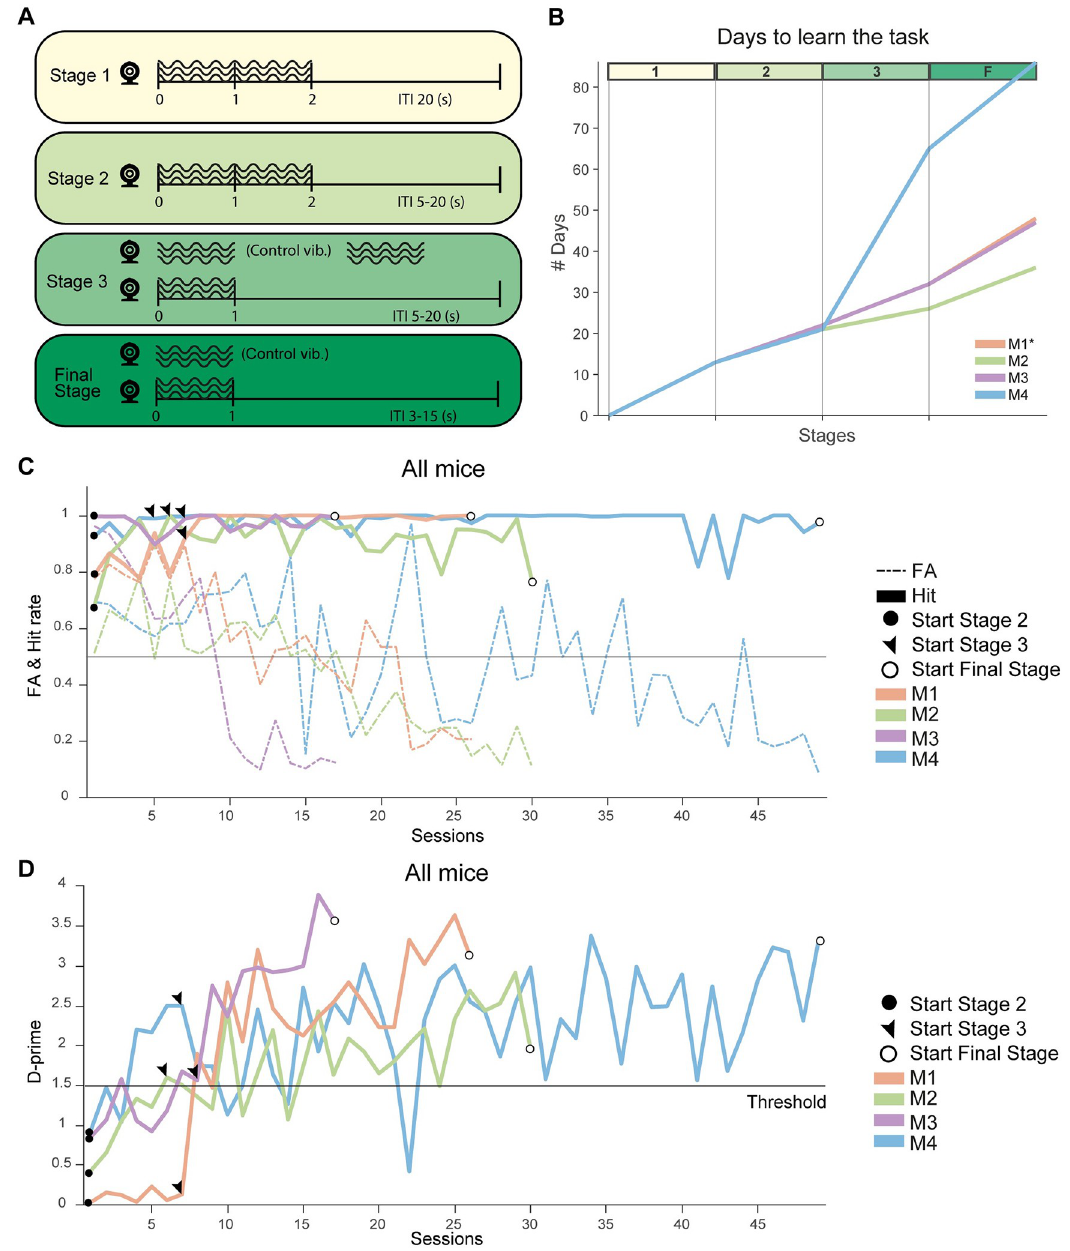
Fig 2. Training stages and mice performance. (A) Schematic representation of the training Stages. From top to bottom: Stages 1, 2, 3 and Final Stage (each characterized by a different colour, from yellow to dark green). The black circle and waves represent the vibratory motors and their stimuli. Stimulus time and ITIs are longer in the beginning and are reduced across stages. Control vibrations are introduced in Stage 3 and in the Final Stage. (B) Average Stage progression (measured in days) for all mice. The y axis shows the number of days. Coloured bars on the top indicate the corresponding training stage. Orange, Green, Violet and Blue lines are the learning progression curve of each mouse (M1-4). Values for M1 overlap with those of M3, thus its curve is hardly visible in the graph. (C) Time course of Hit and FA rates (solid and dashed lines, respectively) across Stage 2 and 3 all four mice (same colour coding as in panel B ). The grey line at 50% defines the chance response level. This figure shows how FAs are decreasing across sessions, gradually, from 90% in the first session of Stage 2, to less than 25% at the end of Stage 3. Moreover, more than 85% of responses are Hit responses, a value that stays stable across sessions. (D) D-prime values across Stages 2 and 3 for all four mice (same colour coding as in panel B ). There was a consistent increment in performance along Stage 2 and 3. The horizontal line indicates the D-prime of 1.5 that is commonly considered to be satisfactory performance. Note that both D-prime and FA rate were used to determine the transition from Stage 3 to the Final stage. ITI : intertrial interval; FA : false alarm .